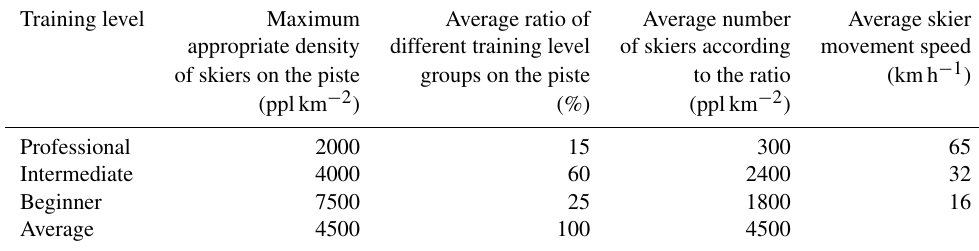
Table 5. The density ( d ) index and average sportsmen movement speed.